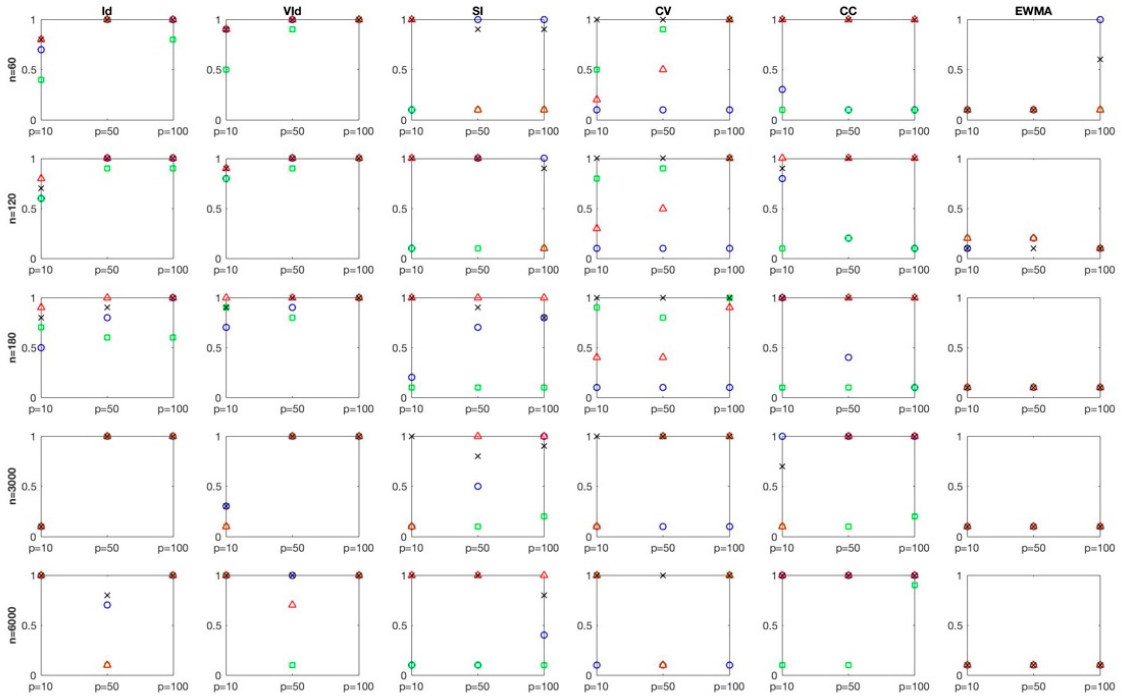
Figure 4. Optimal shrinkage intensity parameters for which the Frobenius norm is minimized. Each column corresponds to a specific target matrix: from left to right, the Identity, the Variance Identity, the Single-Index, the Common Covariance, the Constant Correlation, and the EWMA, respectively. Each row corresponds to a different n : in ascendant order from n = 60 (first row) to p = 6000 (fifth row). In each subplot, the MV portfolio is blue circle-shaped; the IV is green-square shaped; the ERC is red-triangle shaped; and the MD is black-cross shaped.